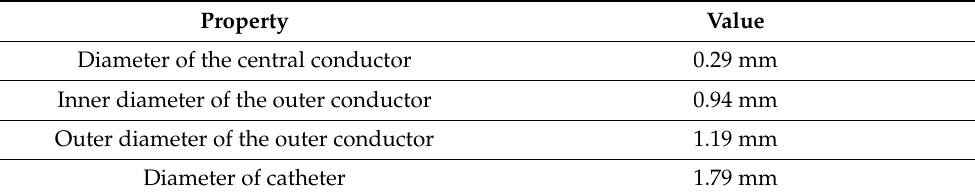
Table 2. Size of microwave antenna.